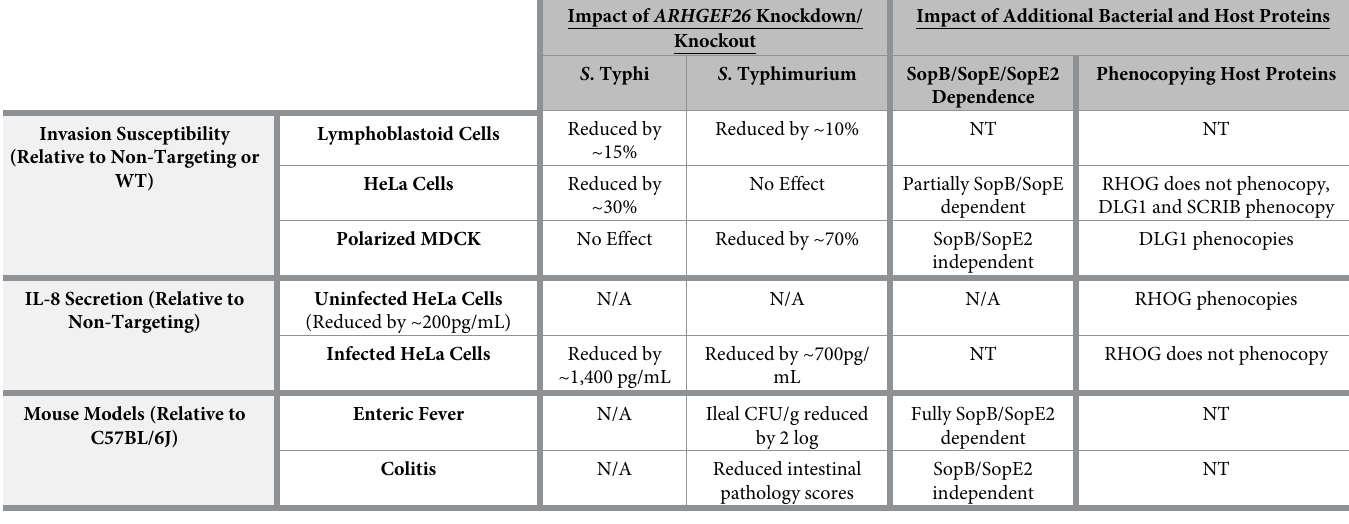
Table 1. ARHGEF26 has context-dependent and pleotropic roles during Salmonella